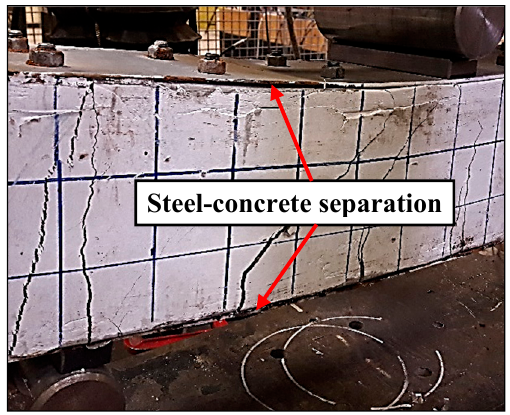
Figure 10. Steel–concrete separation in Rub-B specimen.